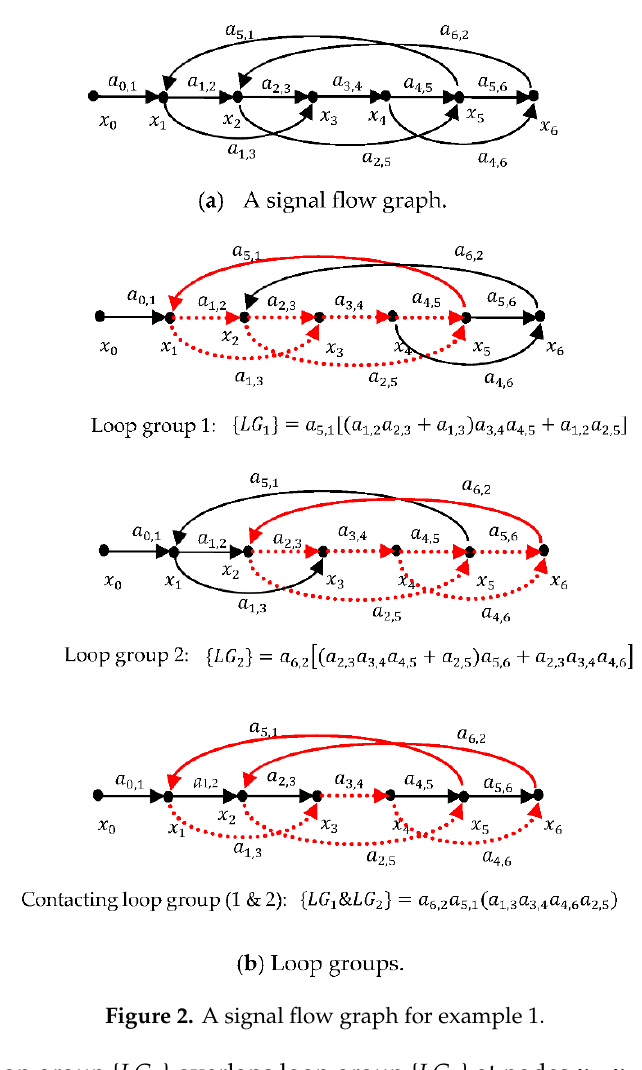
Figure 2. A signal flow graph for example 1.